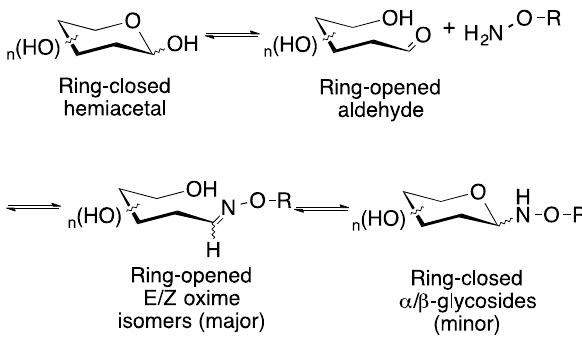
Figure 1. Reaction of a typical reducing aldose sugar with an aminooxy-containing compound in a protic solvent such as water results in the initial formation of the ring-opened E/Z oximes, which over time in aqueous solution, will equilibrate with the ring closed glycosides.